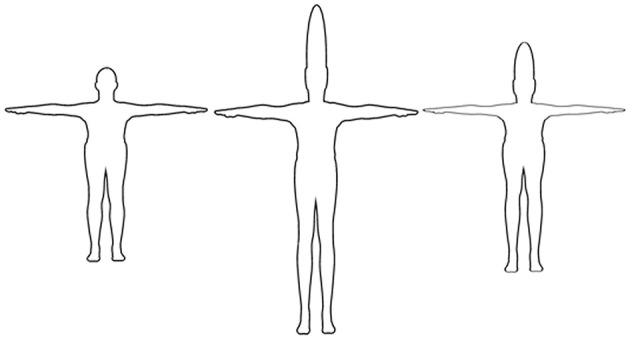
Physical and perceived bodies. Average bodies across participants: (Left) physical, based on the measured body heights; (Middle) perceived, based on the pointed-out body part locations in the VR headset; (Right) perceived, based on the pointed-out body part locations in the Pano-LSID. Scaling is in the vertical dimension only and the arms are not considered in the scaling.